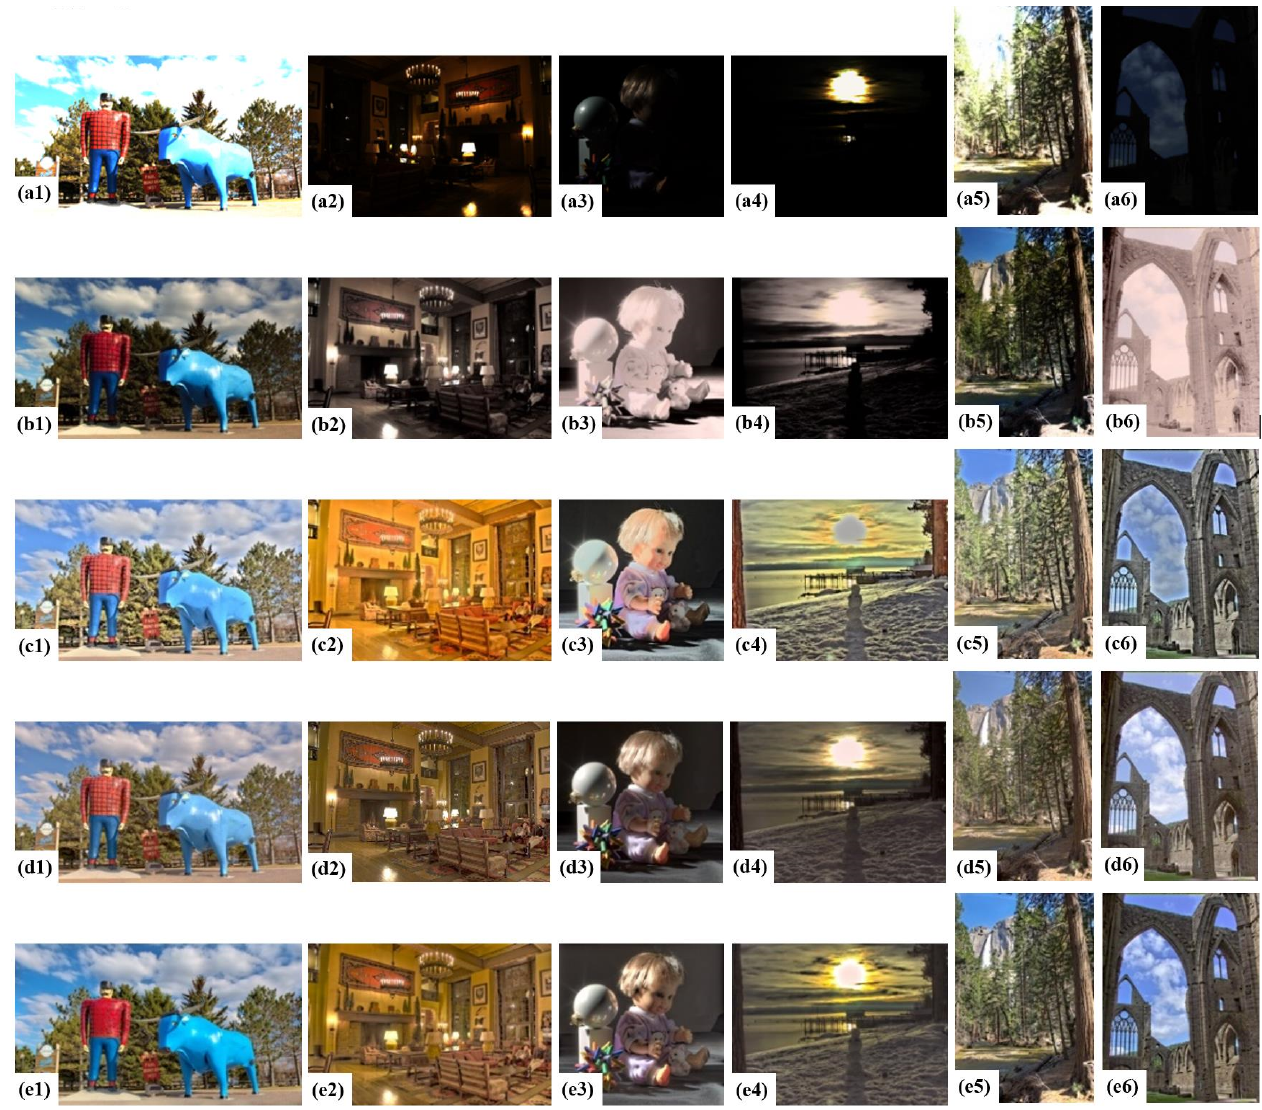
Figure 3. Images after tone mapping by four algorithms: ( a1 – a6 ) tone mapped images performed by linear normalization mapping method; ( b1 – b6 ) images processed by GF; ( c1 – c6 ) images operated using MSD; ( d1 – d6 ) images processed by iCAM06; and ( e1 – e6 ) images operated by the proposed algorithm, iCAM06-m.